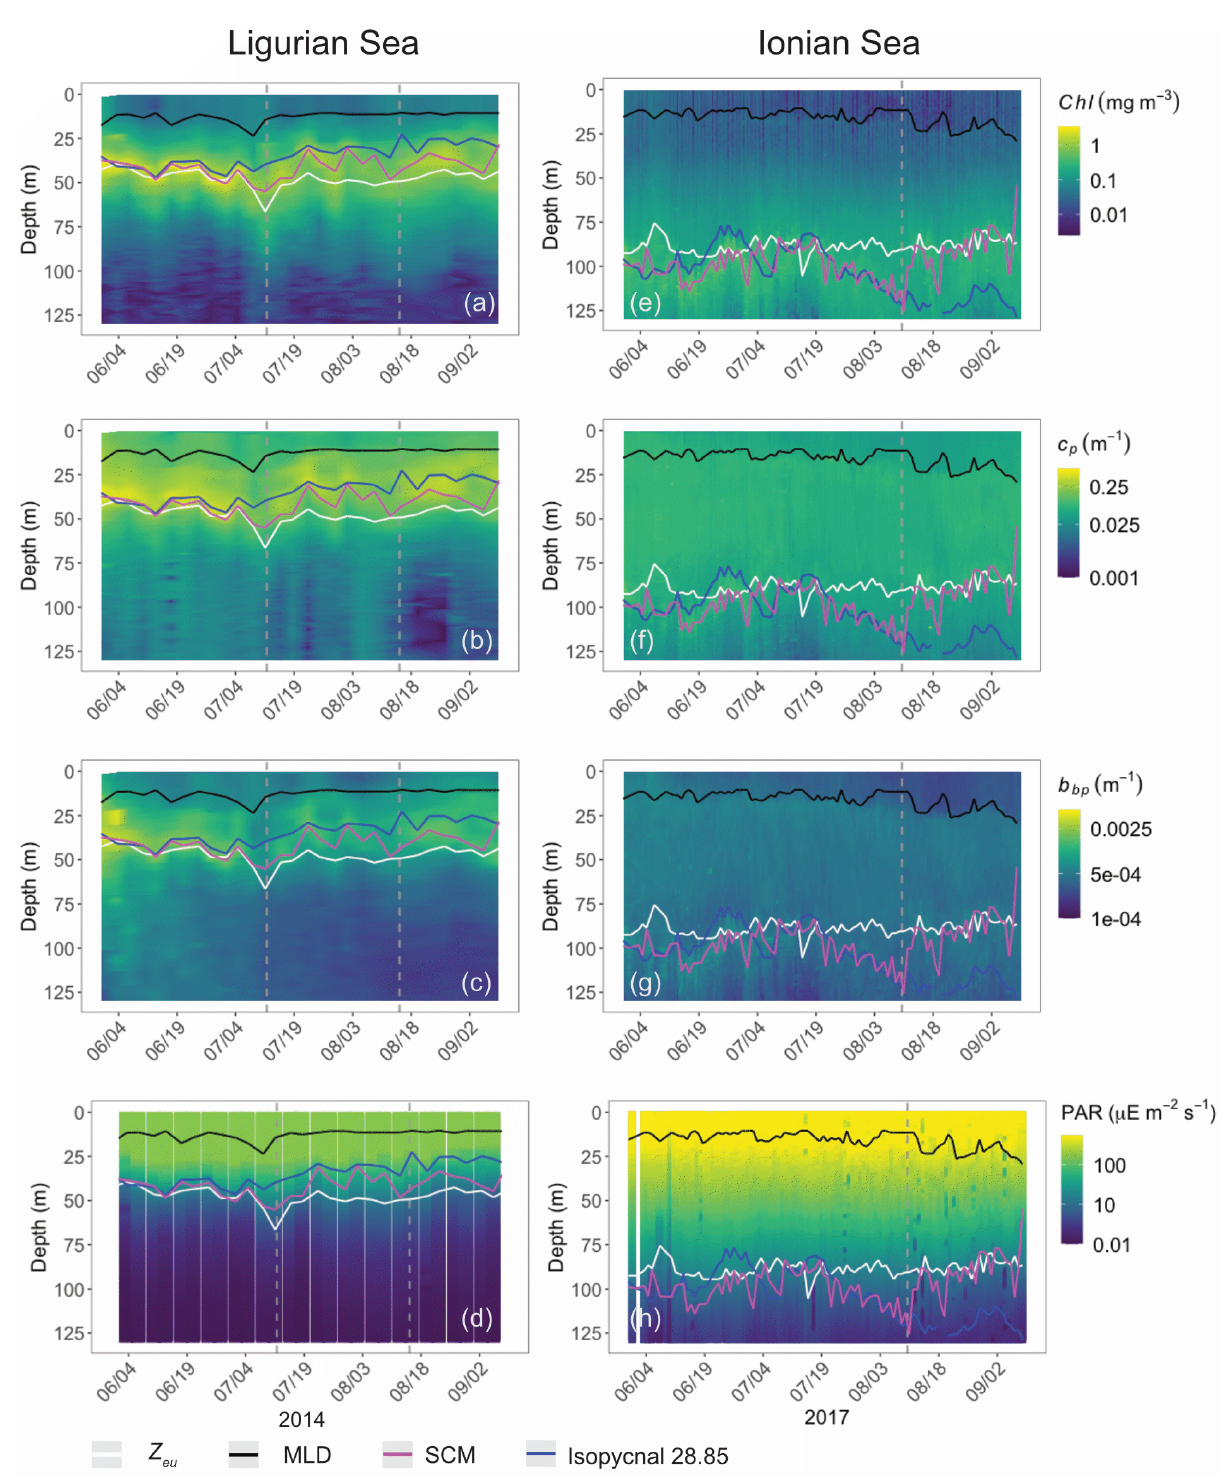
Figure 3. Time series of the vertical distribution of the Chl (a, d) , b bp (b, e) , c p (d, f) and instantaneous midday PAR (d, h) , in the Ligurian Sea (a–d) and the Ionian Sea (e–h) . The euphotic depth ( Z eu ; white line), the mixed-layer depth (MLD; black line), the depth of the SCM (magenta line) and the depth of the isopycnal 28.85 expressed as σ t (blue line) are superimposed onto the bio-optical time series. The dashed lines indicate the dates at which the c p and the b bp values in the SCM layer reach a minimum. Please note that the date format in this figure is